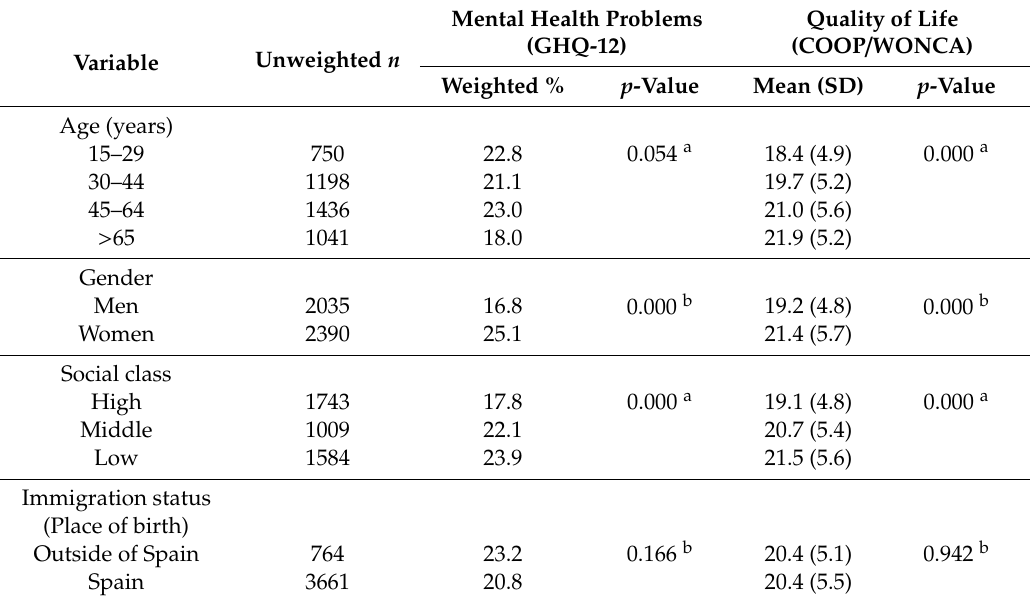
Note. Higher COOP / WONCA scores mean lower health-related quality of life. a Chi-square for linear trends or ANOVA for linearity. b Chi-square for homogeneity or ANOVA for equal